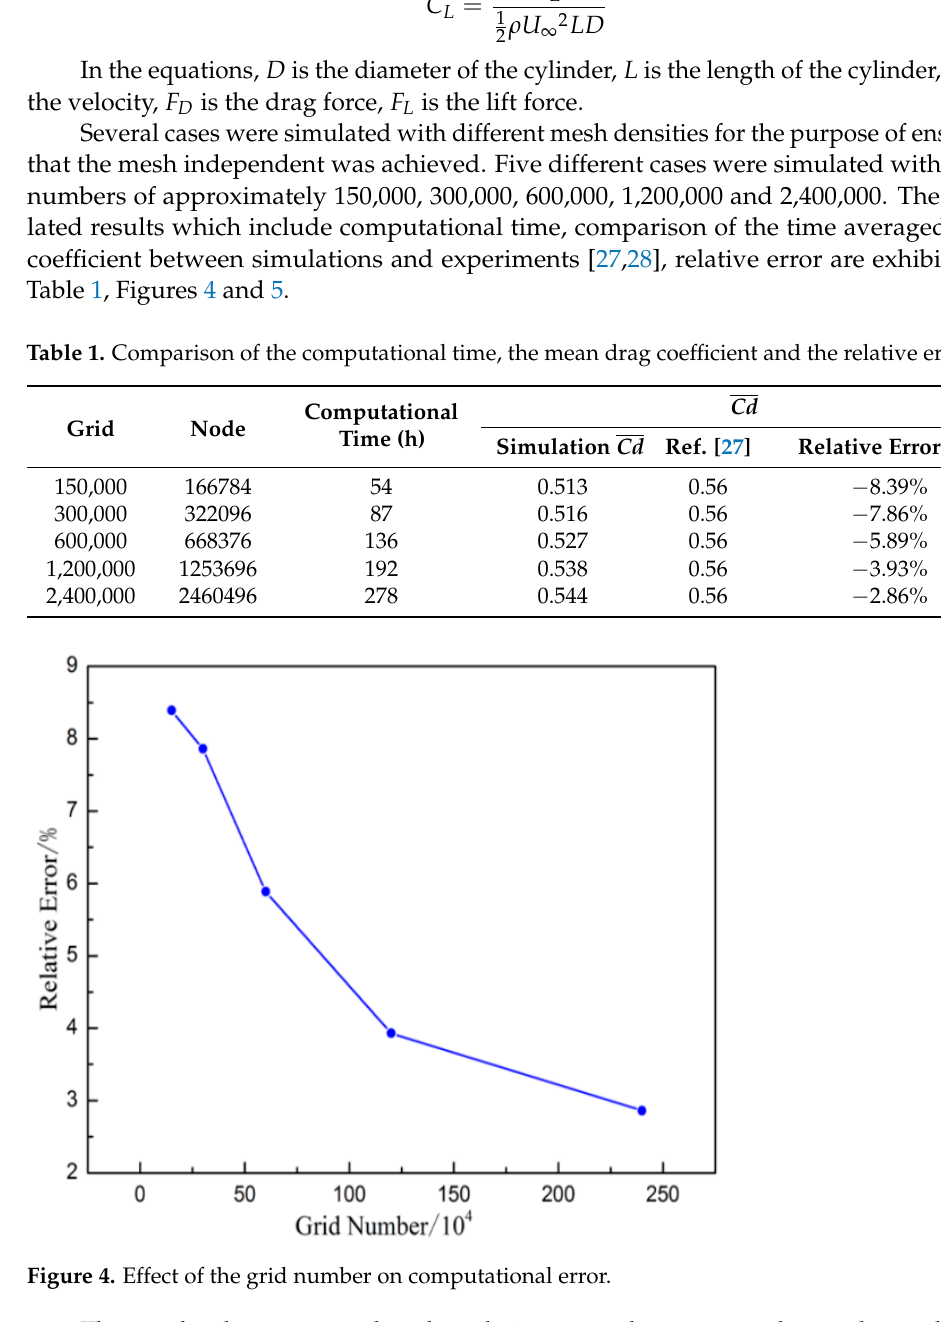
Figure 5. Effect of the grid number on computational time.